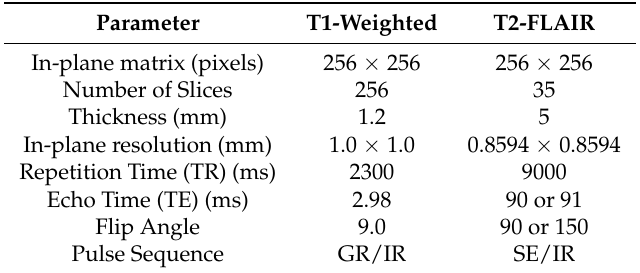
Table 1. Data acquisition protocol